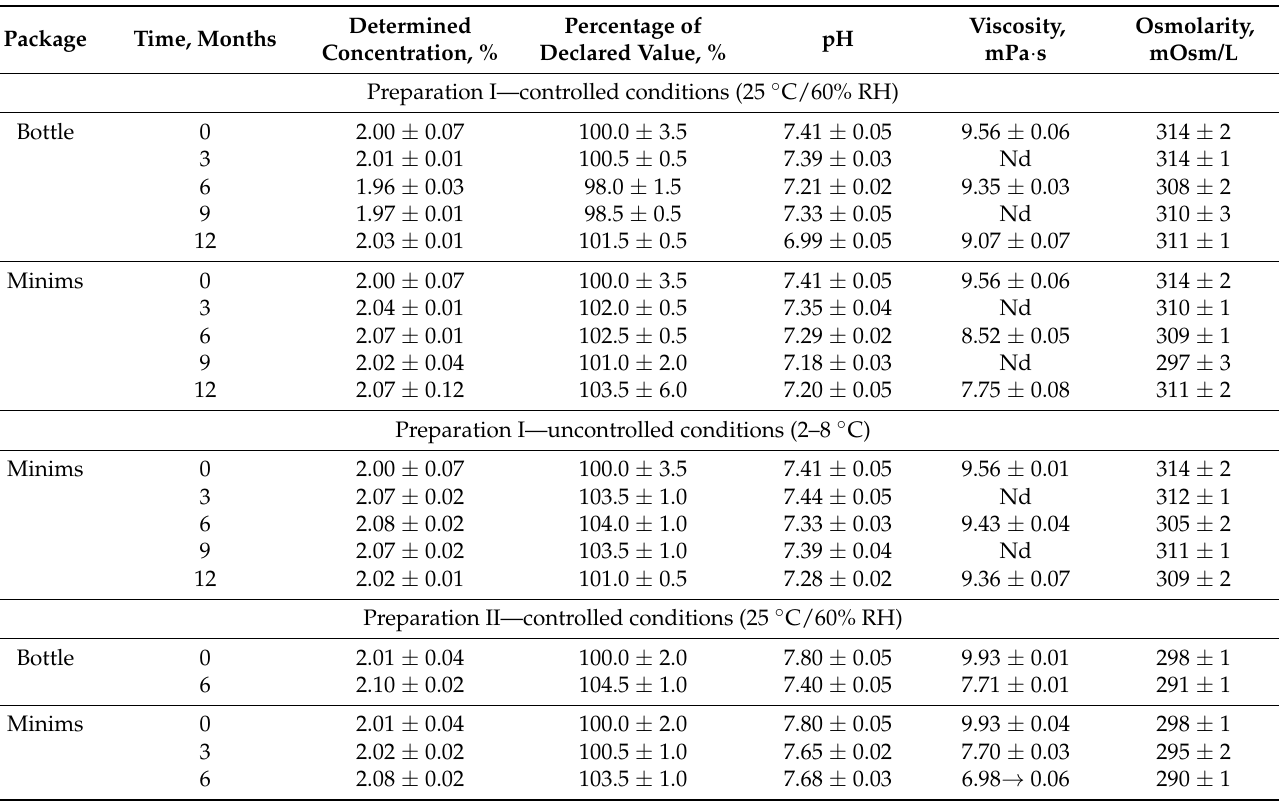
Table 5. Stability of choline salicylate eye drops formulated using Preparations I and II stored under controlled (25 ◦ C/60% RH) and uncontrolled conditions (2–8 ◦ C) in bottles and minims—results of CS determinations by HPLC and measurement of pH, viscosity, and osmolarity (mean ± SD, n =